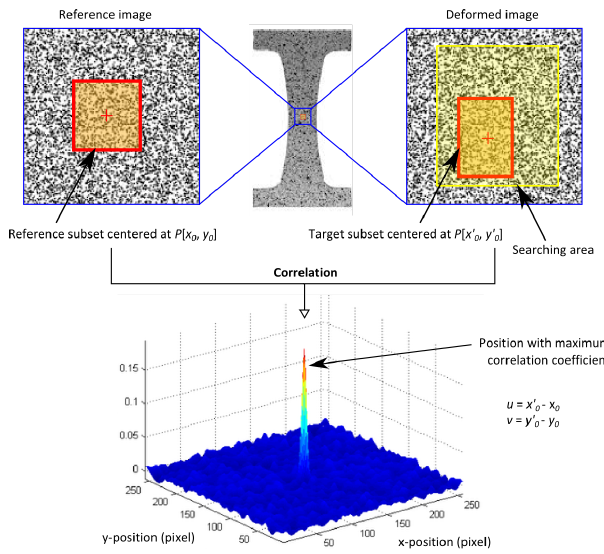
Figure 1. Example of the subset tracking procedure using